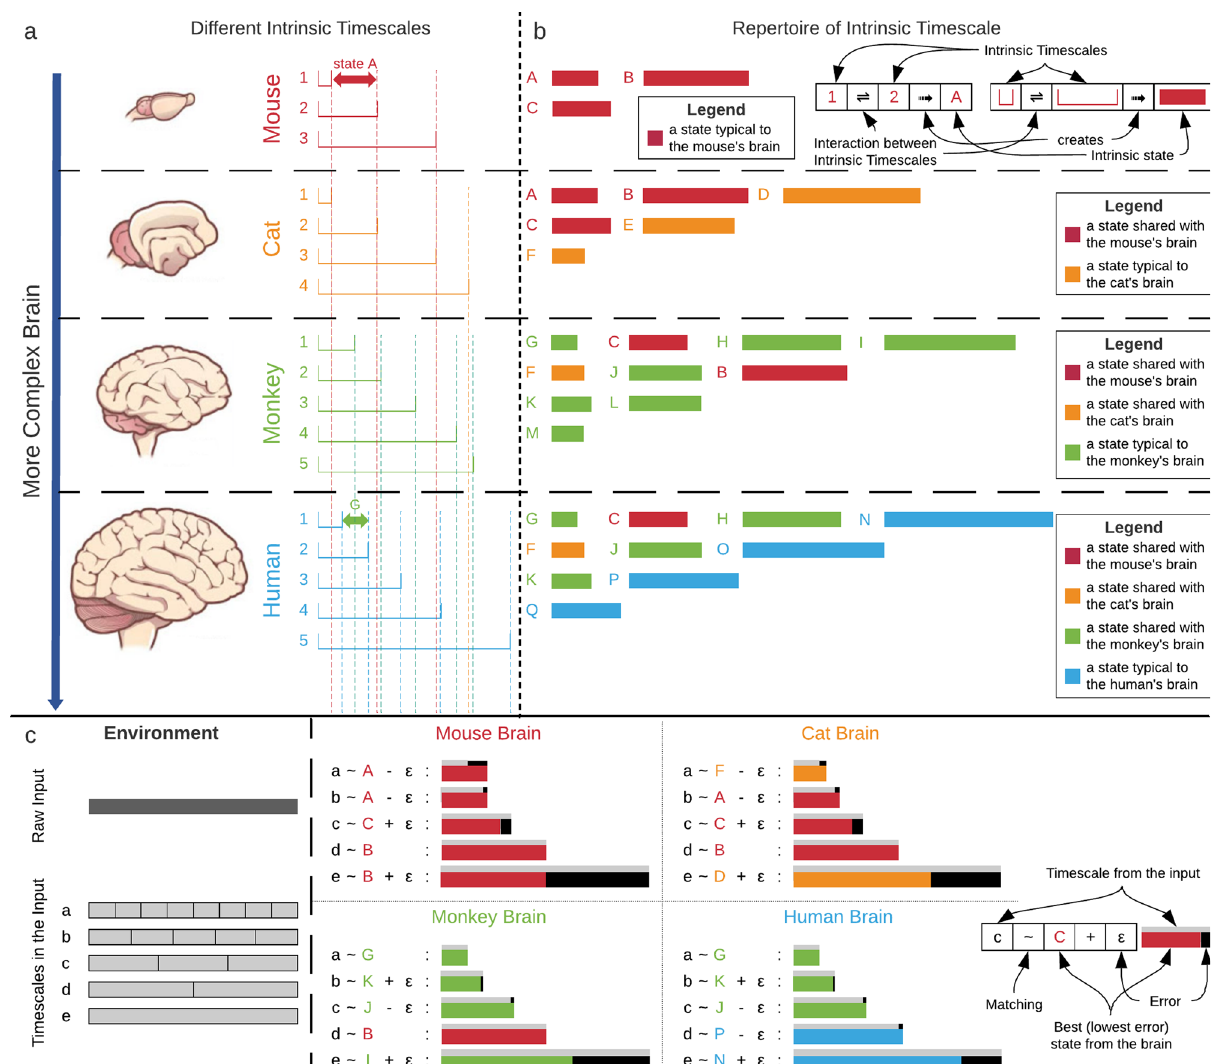
Fig. 4 Evolutionary cross-species stochastic matching of the input. All parts are for illustration purpose only and the sequence of brains is not intended to represent any evolutionary hierarchy. a Intrinsic timescales in the brains ’ of four sample species. On a general scale, a more complex brain has higher number of intrinsic timescales (e.g., human vs. mouse). Also, different brains may have timescales with similar or different lengths. b The interaction between different intrinsic timescales may create species ’ repertoire of timescales. Each state in the repertoire is the result of the interaction between a pair of timescales. For example, state A is the result of the interaction between timescales 1 and 2. Here, for the sake of simplicity the interaction is de fi ned as the difference between the lengths of two timescales. Although, the timescales themselves are unique to each species ’ brain, the interactions (states) can be shared between different species, e.g., state C is shared between all four sample species. So, the repertoire of states in each species ’ consists of some states that are typical to that species and some states that are shared with other species. c The interaction between the environment and the brain happens through the matching of timescales. On the left, we have the environment and a sample input which contains several timescales with different lengths (a, b, c, d, e). On the right, the matching between the input and each species ’ brain is illustrated. Each timescale in the input is matched to the best state from the repertoire of timescales. The best state is the state that yields the least error. The brain clip arts are credited to ref. 115